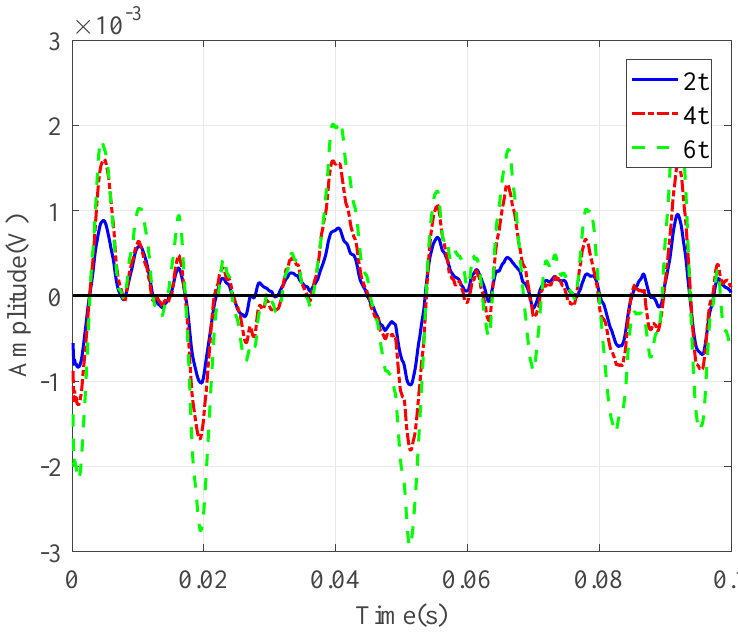
Figure 10. Time-domain leak noise signals collected by PVDF wire sensors with different winding numbers.